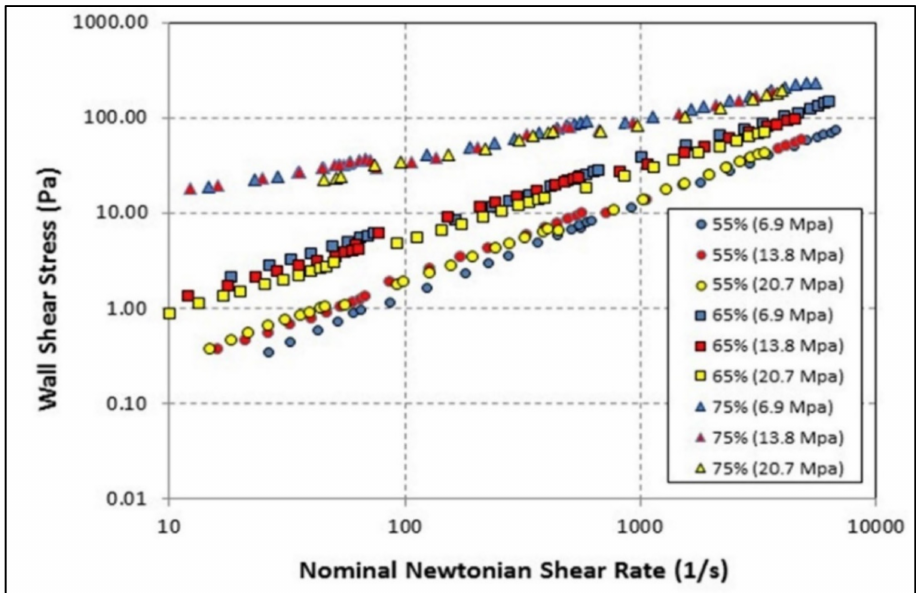
Figure 8. The rheogram shows the secondary effect of pressure on foam rheology (Reprinted with the permission from Akhtar et al. [55]). Copyright 2017, Elsevier